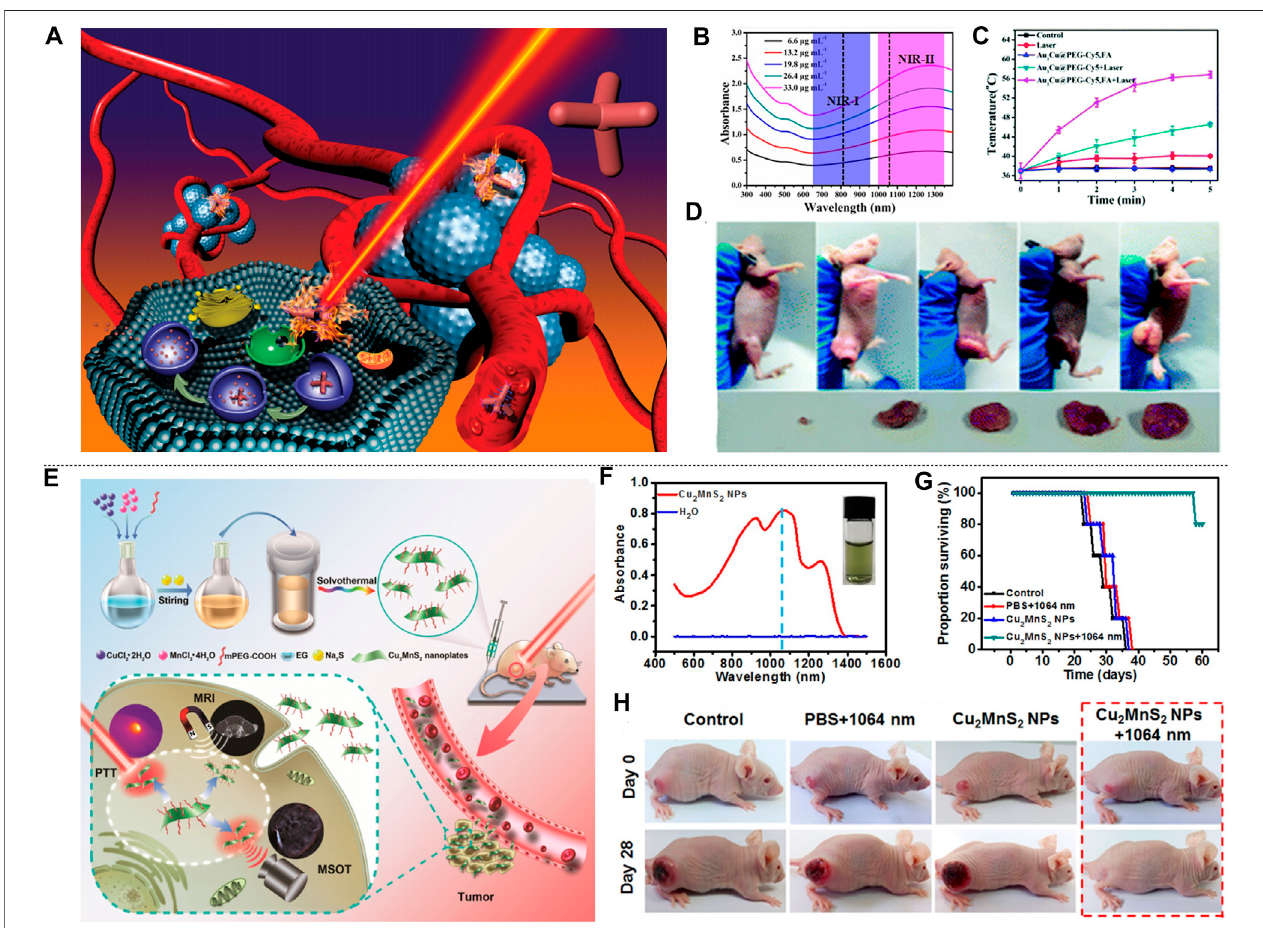
FIGURE 11 | PTT of oral cancer, sarcoma cancer and colon cancer. (A) System diagram of Au 3 Cu TPNCs. (B) Absorption spectrum of Au 3 Cu TPNCs. (C) The temperature change of tumor in mice with KB. (D) the comparison of tumors in fi ve groups of mice (reproduced from (Wang et al., 2018) with permission from Royal Society of Chemistry). (E) The synthesis of Cu 2 MnS 2 NPs and the process of photothermaltreatment ofmicewith S180. (F) Absorption spectrum of Cu 2 MnS 2 NPs. (G) Survival rate of four groups of mice. (H) Comparison of tumor size of four groups of mice (reproduced from (Ke et al., 2017) with permission from